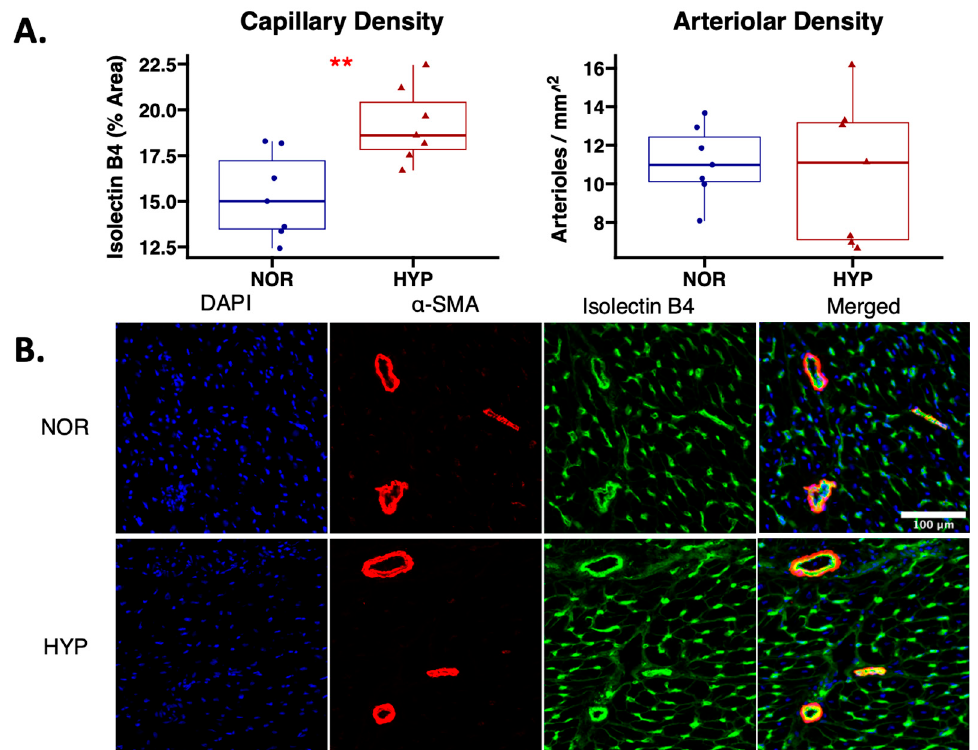
Figure 3. Hypoxia-modified EVs increased capillary density to chronically ischemic myocardium compared to normoxia EVs. ( A ) Swine treated with hypoxia-modified (HYP, n = 7) EVs had improved capillary density as measured by isolectin B4 immunofluorescent staining compared to treatment with normoxia serum-starved EVs, without changes in arteriolar density as measured by α -smooth muscle actin staining. The upper and lower borders of the box represent upper and lower quartiles; the middle horizontal line represents the median; the upper and lower whiskers represent maximum and minimum values. ** p < 0.01. ( B ) Representative images (20×) of ischemic myocardial tissue stained with α -smooth muscle actin ( α -SMA) for arteriolar density (red), isolectin B4 for capillary density (green), and 4 ′ ,6-diamidino-2-phenylindole (DAPI) for nuclei staining (blue).